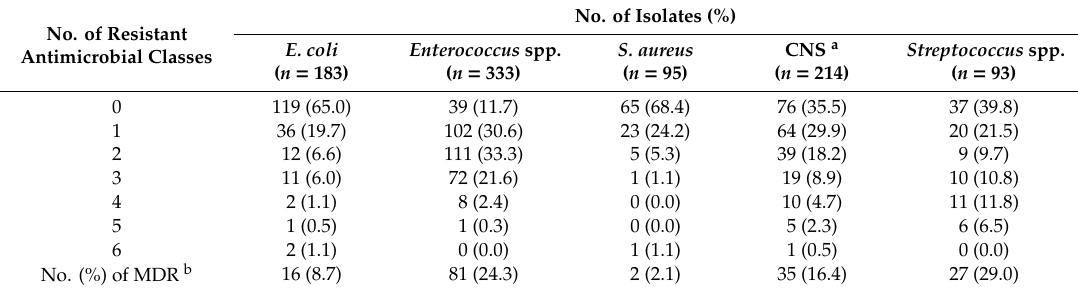
Table 5. Distribution of multidrug resistance of 918 pathogens isolated from bulk tank